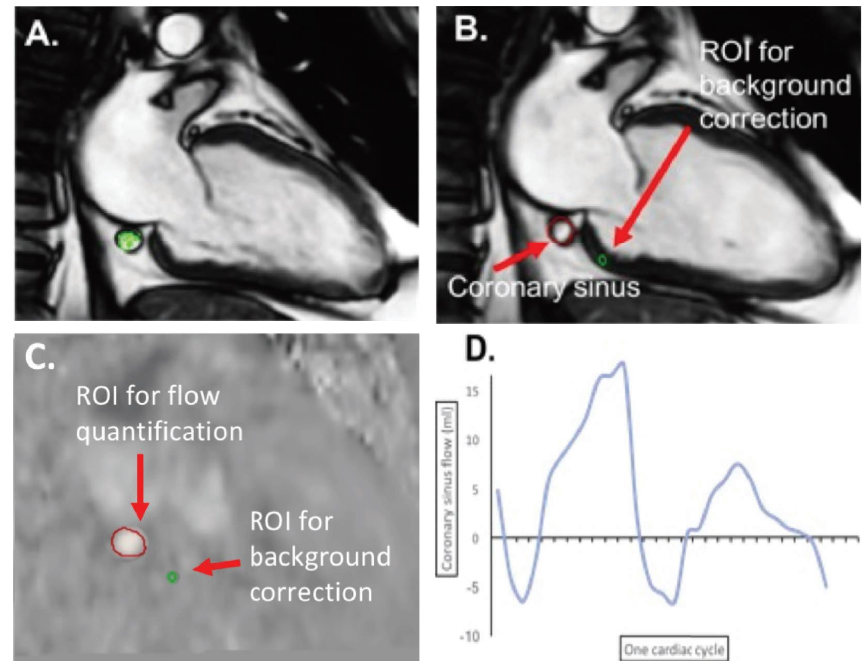
Figure 1: Method of coronary sinus fow quantifcation. Te 4D fow data are loaded alongside the two-chamber view where the coronary sinus can be visualised. Alignment is checked by visualising the through-plane 4D fow at the CS using the SSFP images (a). Te CS is contoured in all images. A second ROI, on the nearby myocardium, is contoured for background velocity correction (b). A reformatted phase contrast plane is generated through the coronary sinus (c) and contours are copied. Flow was measured over the entire cardiac cycle (d). CS � coronary sinus ; ROI � region of